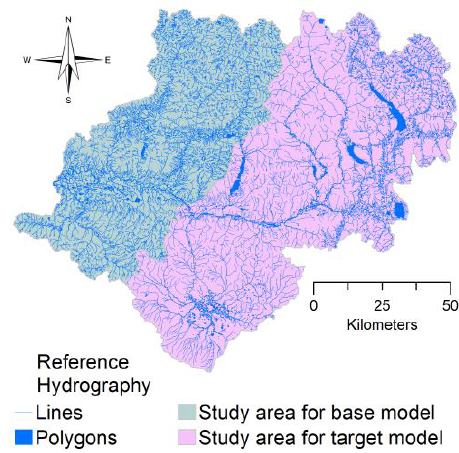
Figure 3. Reference 1:24,000-scale hydrographic features derived from IfSAR data through contracted work for the U.S.